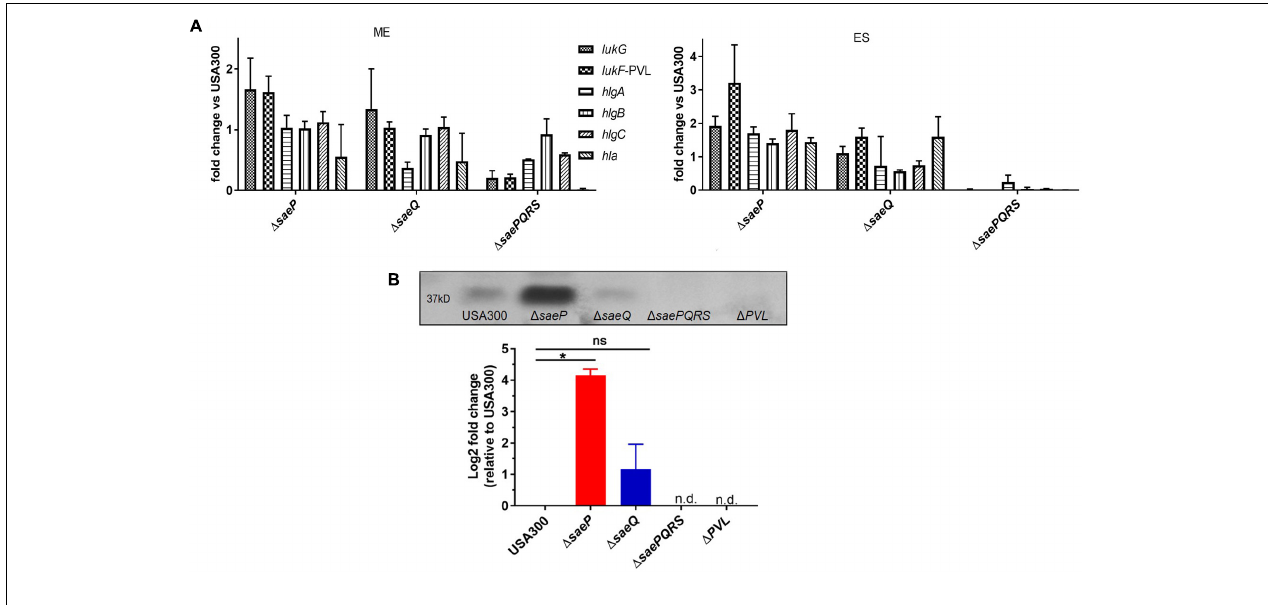
FIGURE 3 | USA300 (cid:49) saeP demonstrates increased transcript abundance of several known SaeR/S-virulence factors. (A) Mean fold-change of known SaeR/S-regulated virulence genes in USA300 (cid:49) saeP and USA300 (cid:49) saeQ relative to USA300 is shown. Transcript abundance was measured using TaqMan R (cid:13) RT-PCR at mid-exponential (ME; left) and early stationary (ES; right) phases of in vitro growth. Transcripts were normalized to gyrB and calibrated to transcript abundance in USA300. Data are from at least two independent experiments. (B) The USA300 (cid:49) saeP strain of S. aureus produces significantly more Panton Valentine Leukocidin (PVL) compared to USA300. (Top) Representative Western blot of PVL protein in supernatants from S. aureus grown overnight. (Bottom) Quantification of PVL was calculated using densitometry as described in Materials and Methods. Data shown are amounts relative to USA300 and presented as the mean ± SEM of three independent experiments. * P ≤ 0.05 One-Way ANOVA with Tukey’s post-test. n.d., not detected.